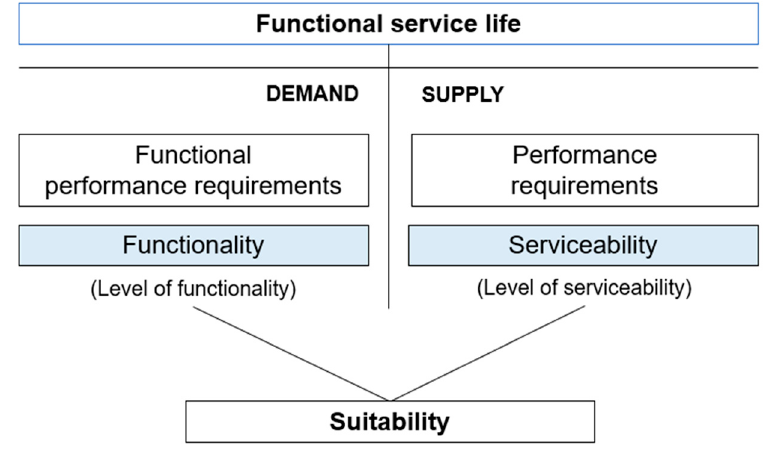
Figure 2. Connection between functionality, serviceability, and suitability.